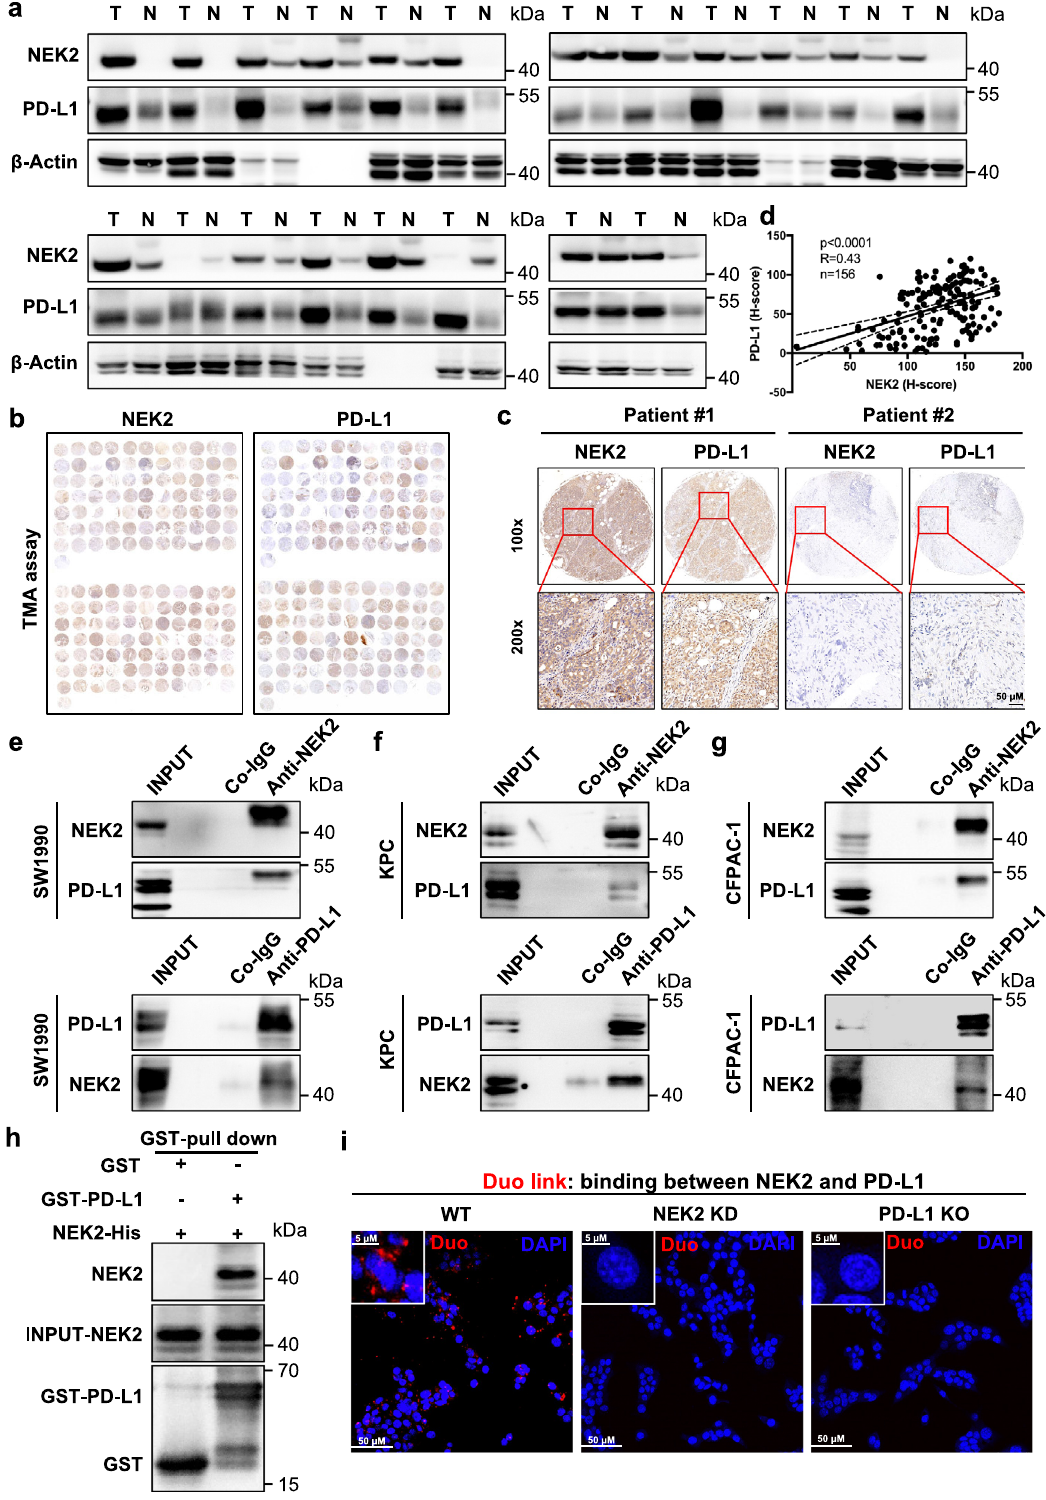
Fig. 4 NEK2 positively correlates and interacts with PD-L1 in pancreatic cancer. a Western blot analysis of NEK2 and PD-L1 in clinical pancreatic tissue samples from patients ( n = 20) (N: Normal pancreatic tissue; T: Pancreatic tumor tissue). b – d Representative images and statistical results of IHC staining of NEK2 and PD-L1 in a tissue microarray ( n = 156). e – g Cell lysates from SW1990, KPC, and CFPAC-1 separately analyzed by IP and Western blotting using the antibodies indicated. Representative image is shown n = 3 independent experiments. h GST-pull down assay of NEK2-His and GST-PD-L1 protein. Representative image is shown n = 3 independent experiments. i Representative images of individual immuno fl uorescence staining of NEK2 and PD-L1 interaction in KPC cells by Duolink assay. The red dots (NEK2/PD-L1 interaction) indicate their interaction. Representative image is shown n = 3 independent experiments. The Spearman correlations and p -values by Spearman ’ s test are indicated in d .